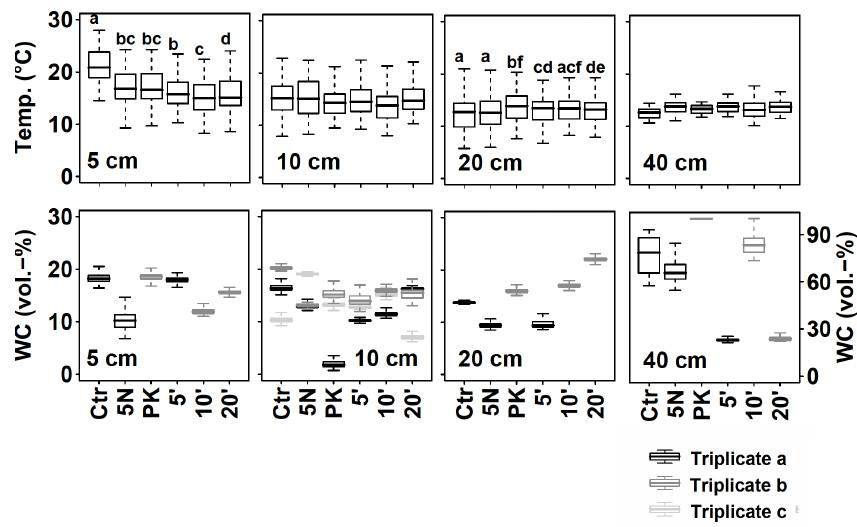
Fig. 3. Box-whisker-plots for soil temperatures at noon (12:00) and volumetric water content for the whole measurement period with fertilization degree. Temperatures in treatments labelled with no letters in common are significantly different at p < 0 . 05 (t-test). In the temperature box plots, one box represents all 3 replicates except for the control, whereas in the water content box plots, each box represents only one replicate. Temp., temperature; Prec., precipitation; WC, water content; Ctr, control; 5 0 , 5NPK; 10 0 , 10NPK; 20 0 ,